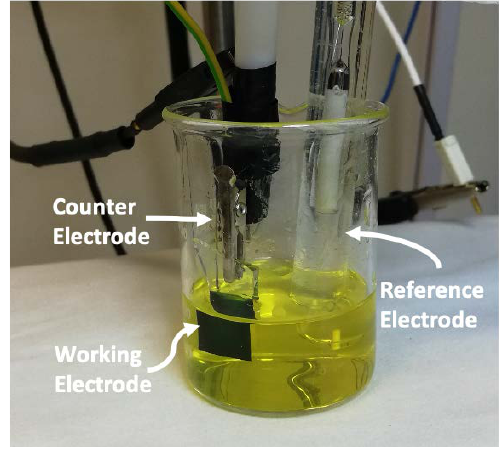
Figure 1. Experimental setup for the electrodeposition of WO 3 films. It is possible to distinguish the working electrode, the counter electrode and the reference electrode. They are immersed into the peroxo-tungstic acid (PTA)